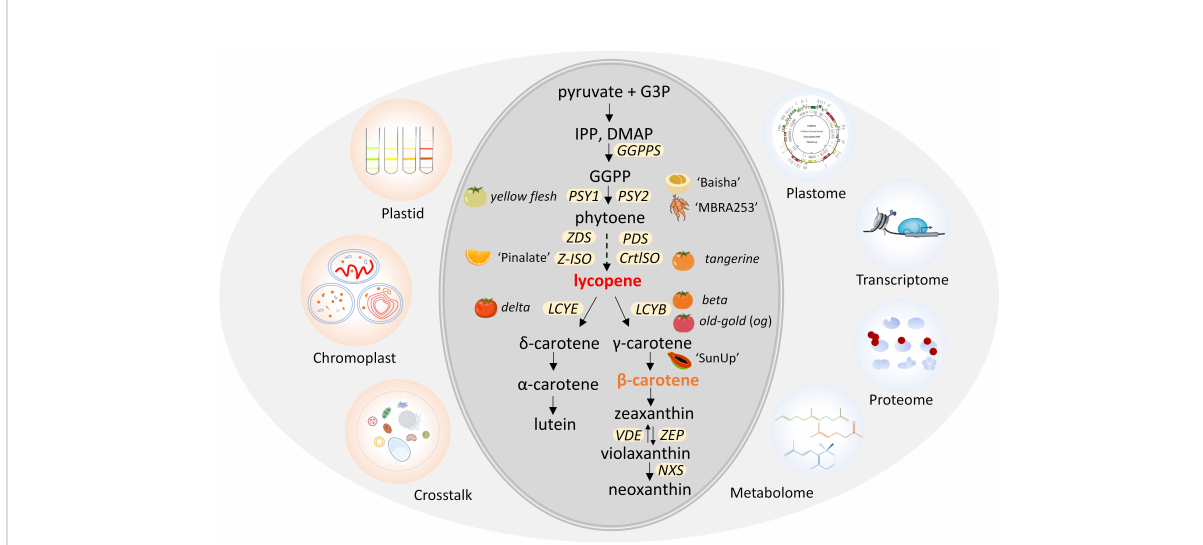
FIGURE 1 Schematic diagram of carotenoids metabolic pathway and omics in plant plastid. Plastids can be isolated for futher biochemical and molecular characterization via omics, including chromoplast with diverse structures. Plastids possess unique crosstalk mechanisms to synthesize and accumulate massive amounts of carotenoids. Mutants or varieties associated with genes for carotenoid biosynthesis are indicated next to the gene. G3P, glyceraldehyde 3-phosphate; IPP, isopentenyl diphosphate; DMAP, dimethylallyl diphosphate; GGPP, geranylgeranyl diphosphate. The yellow ellipses represent carotenoid pathway genes localized in plastids. G GPPS , geranylgeranyl pyrophosphate synthase ; PSY , phytoene synthase ; PDS , phytoene desaturase ; Z-ISO , z -carotene isomerase ; CrtISO , carotene isomerase ; LCYB , lycopene b -cyclase ; LCYE , lycopene ϵ -cyclase ; VDE , violaxanthin de-epoxidase ; ZEP , zeaxanthin epoxidase ; NXS , neoxanthin synthase gene ; ‘ Baisha ’ , loquat ( Eriobotrya japonica) ; ‘ MBRA253 ’ , cassava ( Manihot esculenta) ; ‘ Pinalate ’ , sweet orange ( Citrus sinensis ); ‘ SunUp ’ , Papaya, ( Carica papaya